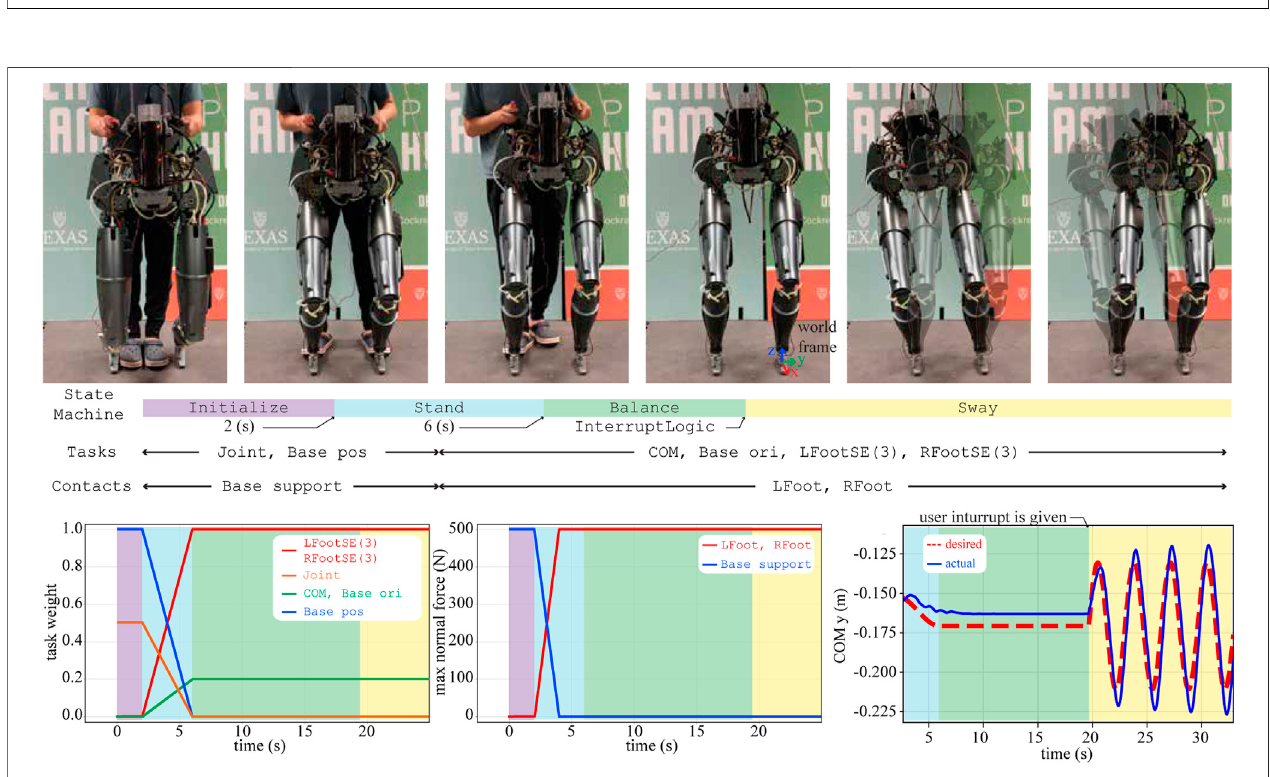
FIGURE 9 | A sequence of snapshots of the balancing experiment are shown. Different sets of tasks and contacts are considered for each behavior phase. Using task weights we impose unilateral contact constraints and implicit hierarchies . The maximum normal forces (i.e., f max r in Eq. 5) during the Stand phase are smoothly changed. The lateral COM trajectories (i.e., COM y) are also illustrated.